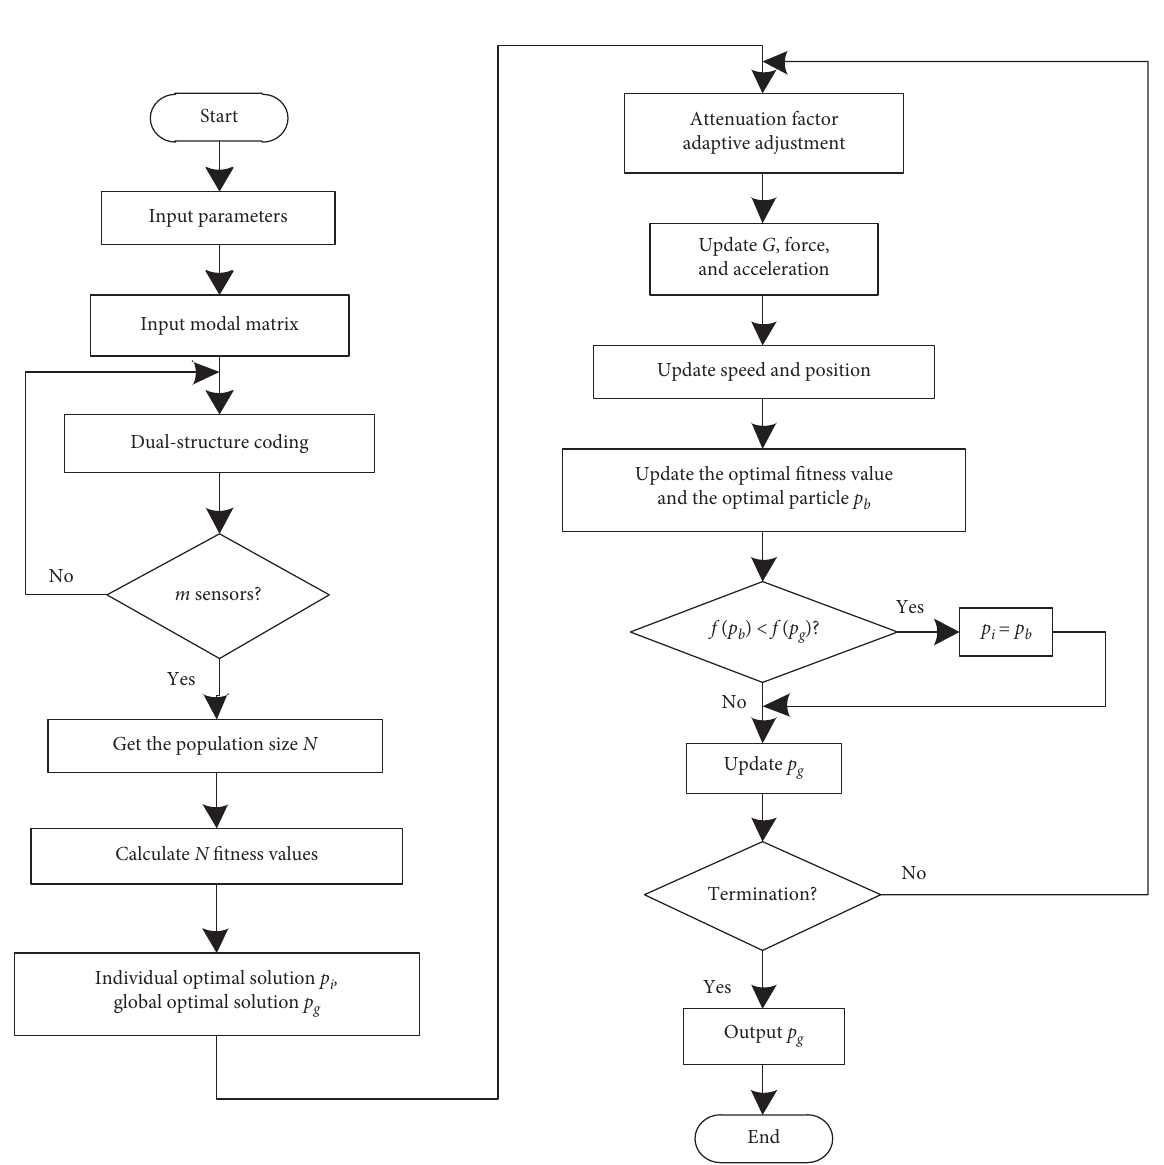
Figure 2: Optimal sensor placement based on